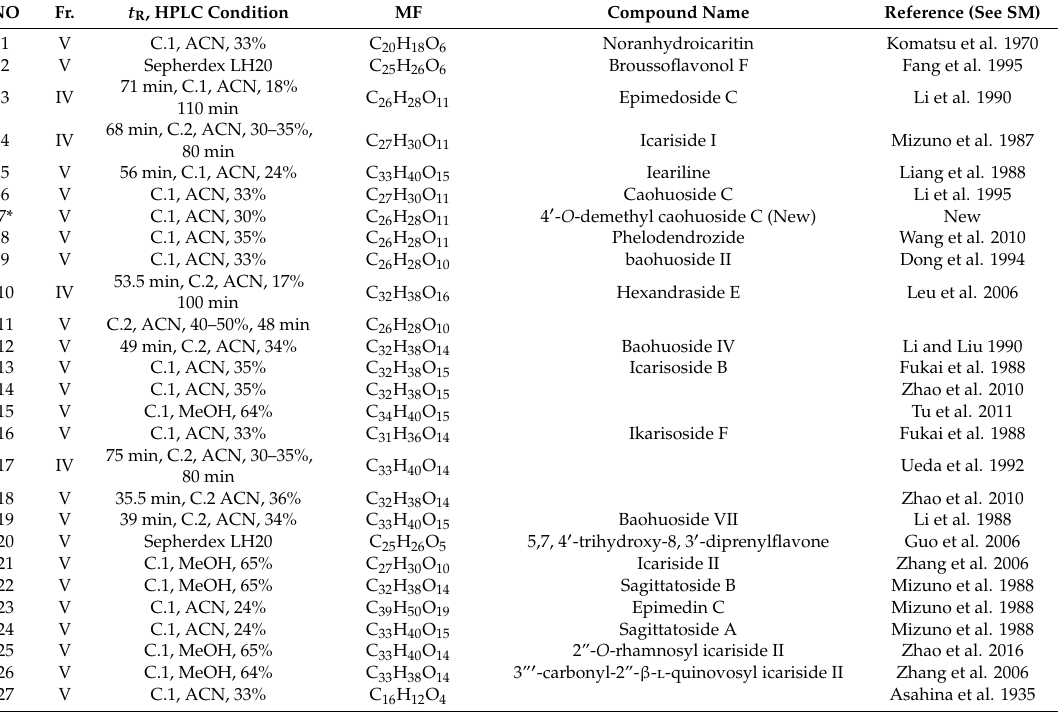
Table 1. Flavanoids (#1–78) isolated from Jing